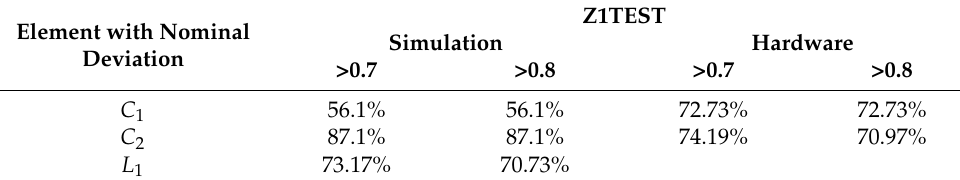
Table 2. Simulation and hardware results of Vilnius chaos oscillator dynamic estimation in master circuit